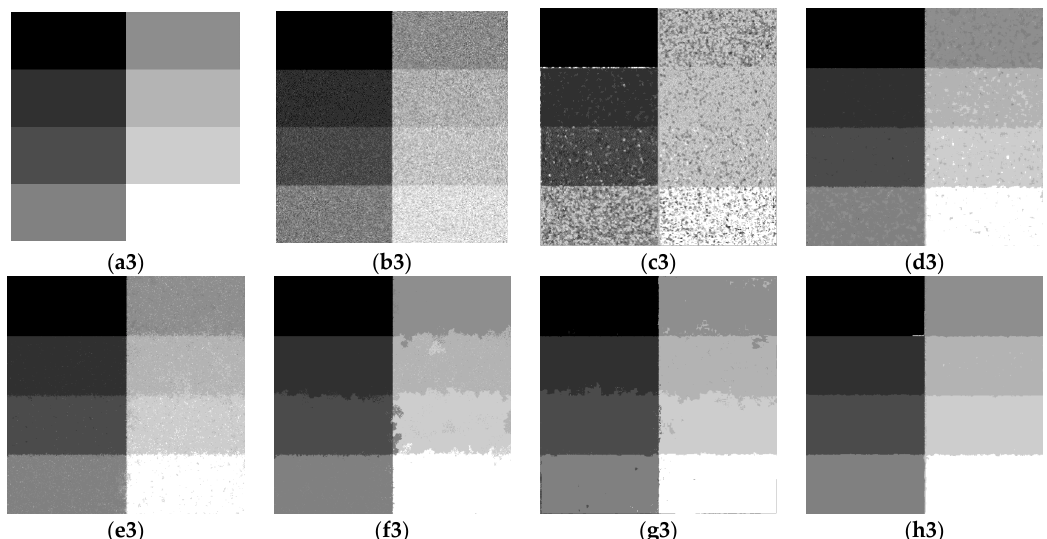
Figure 4. Results of the synthetic SAR images: ( a1–a3 ) ground truths; ( b1–b3 ) synthetic SAR images; ( c1–c3 ) SVM; ( d1–d3 ) CKS ‐ FCM; ( e1–e3 ) CKFF; ( f1–f3 ) SVM ‐ CK; ( g1–g3 ) MWSG; ( h1–h3 ) MAKC, where the numbers represent the sequence index of the images. Table 1. Overall accuracies of different algorithms on the synthetic SAR images.